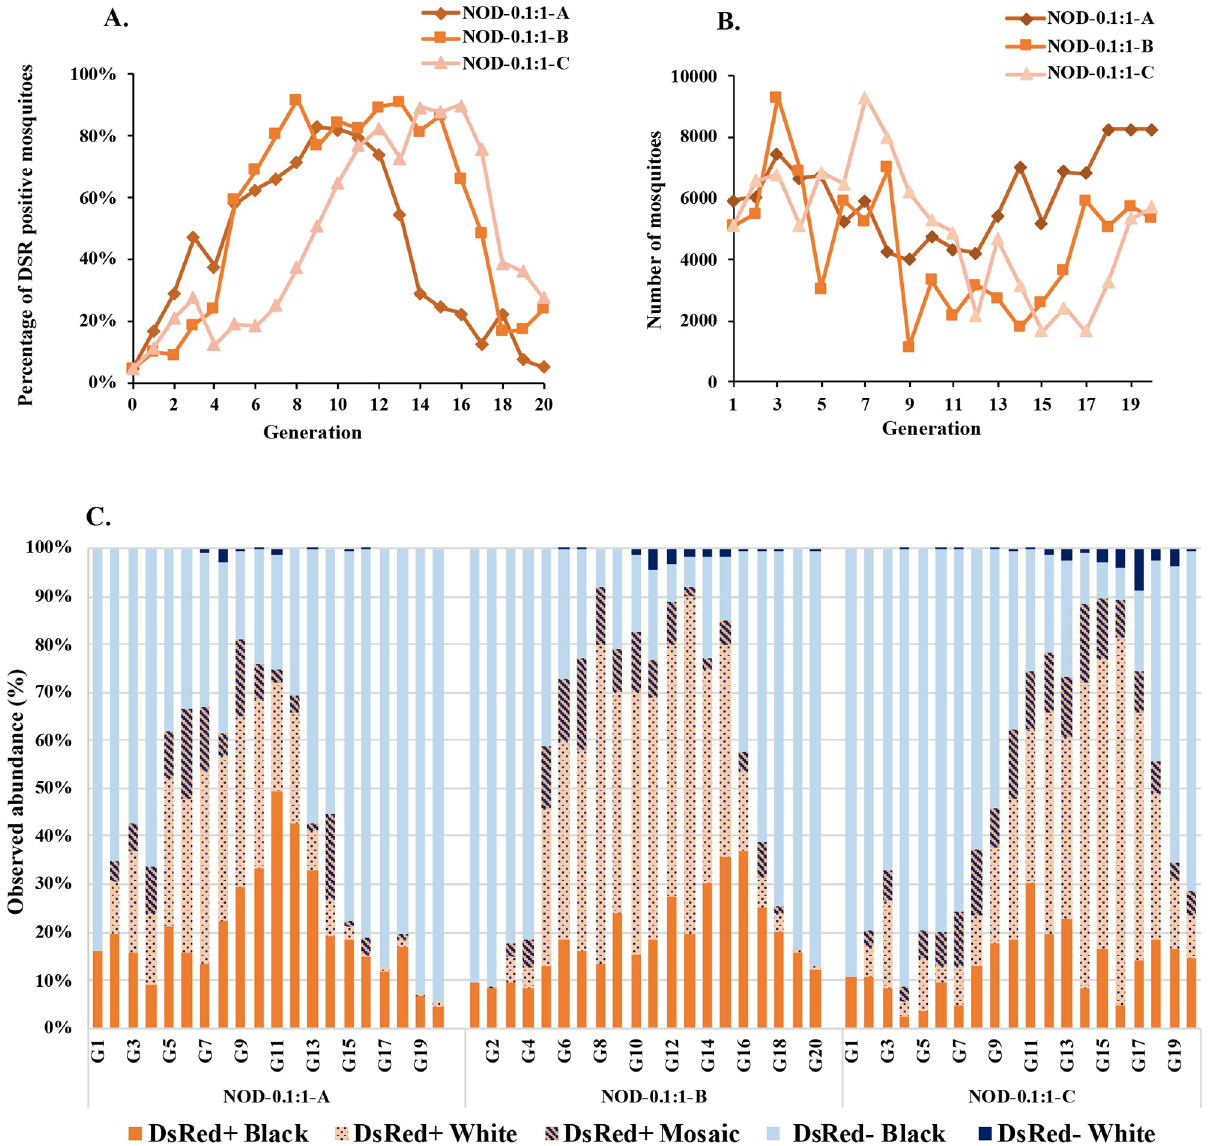
Fig 5. Non-overlapping gene drive (NOD) cage trial with initial releases of 0.1:1 transgenic AsMCRkh2 to wild-type males. Three cages (NOD- 0.1:1A, NOD-0.1:1B and NOD-0.1:1) were seeded initially with 100 wild-type female, 90 wild-type male and 9 AsMCRkh2 male pupae. The resulting next generation larvae, pupae and adults were scored as DsRed-positive (DsRed + , carrying the AsMCRkh2 gene drive cassette) or wild-type. (A) Percentages of DsRed-positive (DsRed + ) adult mosquitoes (Y-axis) in the total population in each cage scored at each generation (X-axis). (B) Total population size (Y-axis) in each replica cage at each generation (X-axis). (C) Abundance in percentages (Y-axis) of eye color and DsRed phenotypes of ~500 randomly-selected pupae per generation in each